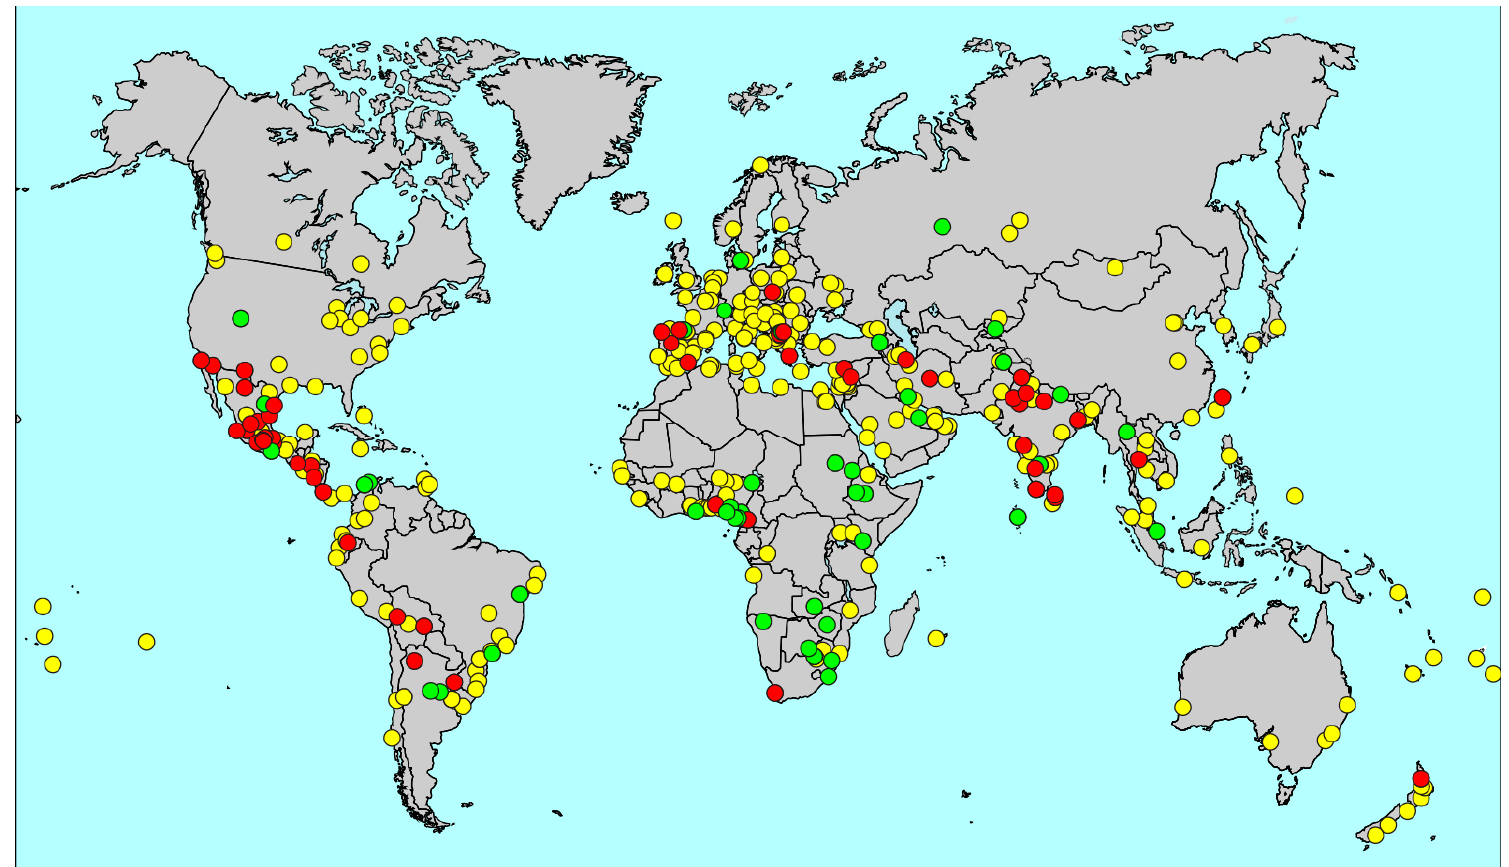
Figure 1. Global Asthma Network (GAN) Centres. Centres registered with GAN identifying those that completed data collection before end of May 2020 (red); registered centres expected to complete GAN Phase I later (green); centres collaborating with GAN but not expected to contribute Phase I data (yellow).